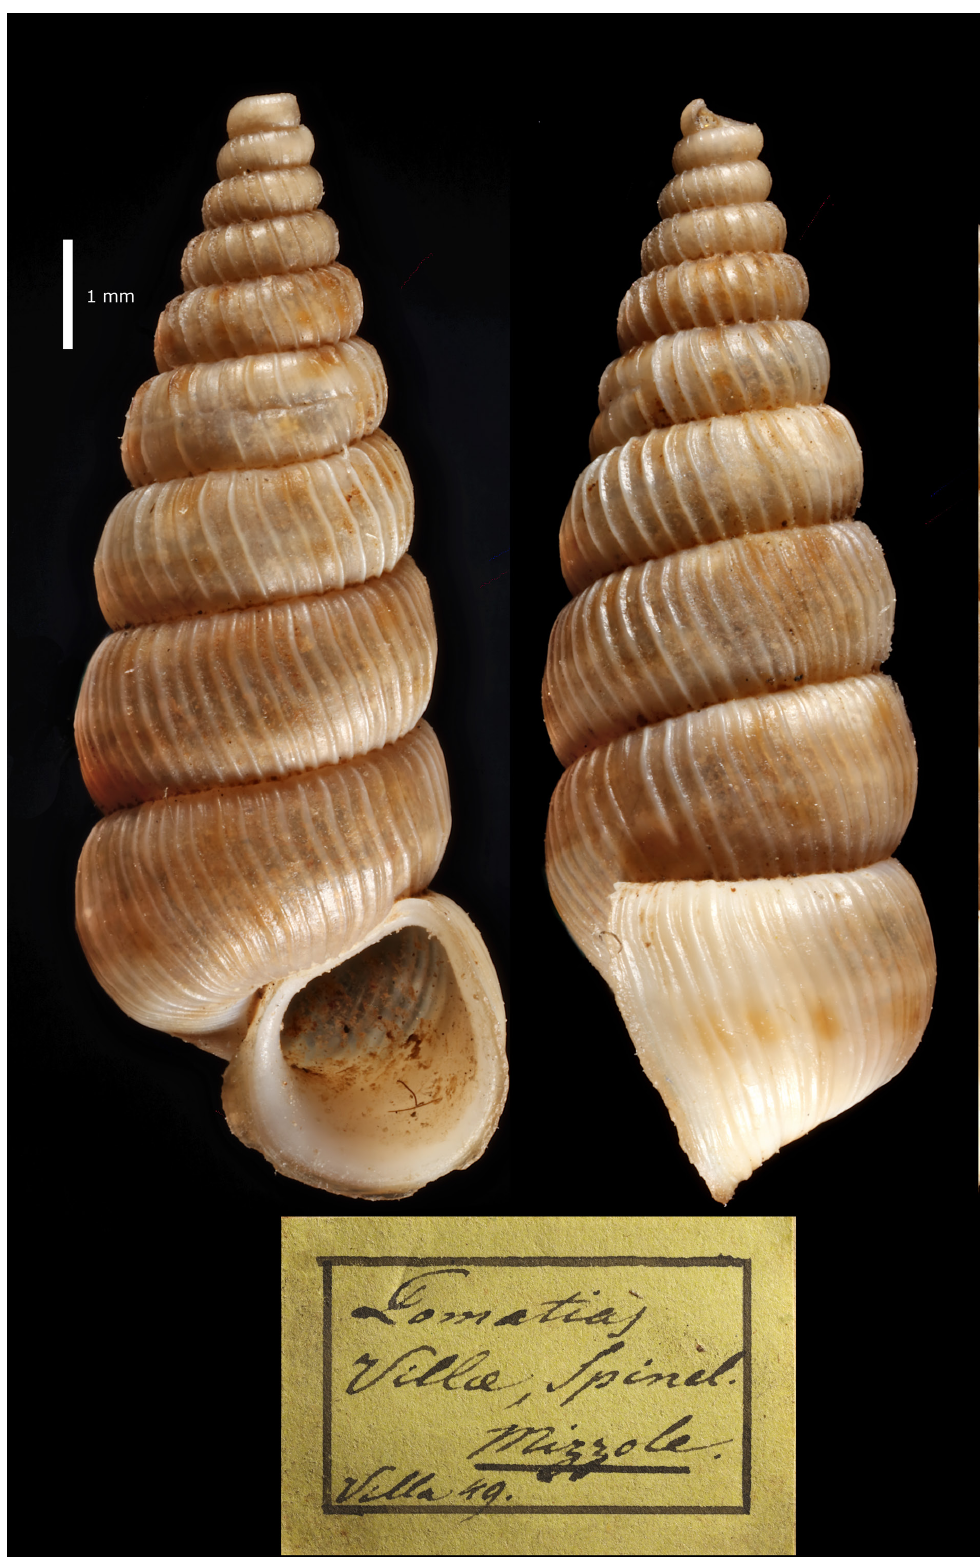
Fig. 19. Cochlostoma ( Clessiniella ) villae (Strobel, 1851), syntype, ♀, at the Museo di Storia Naturale of Parma University, Italy